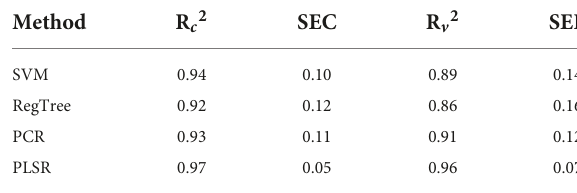
TABLE 4 Comparison of PLSR model performance with other regression